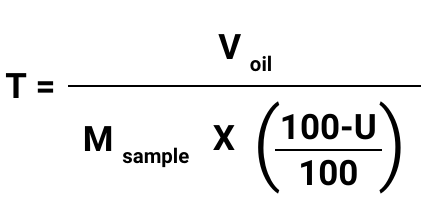
Figure 1. Equation used to determine the mass yield in % of the essential oil on a dry basis.